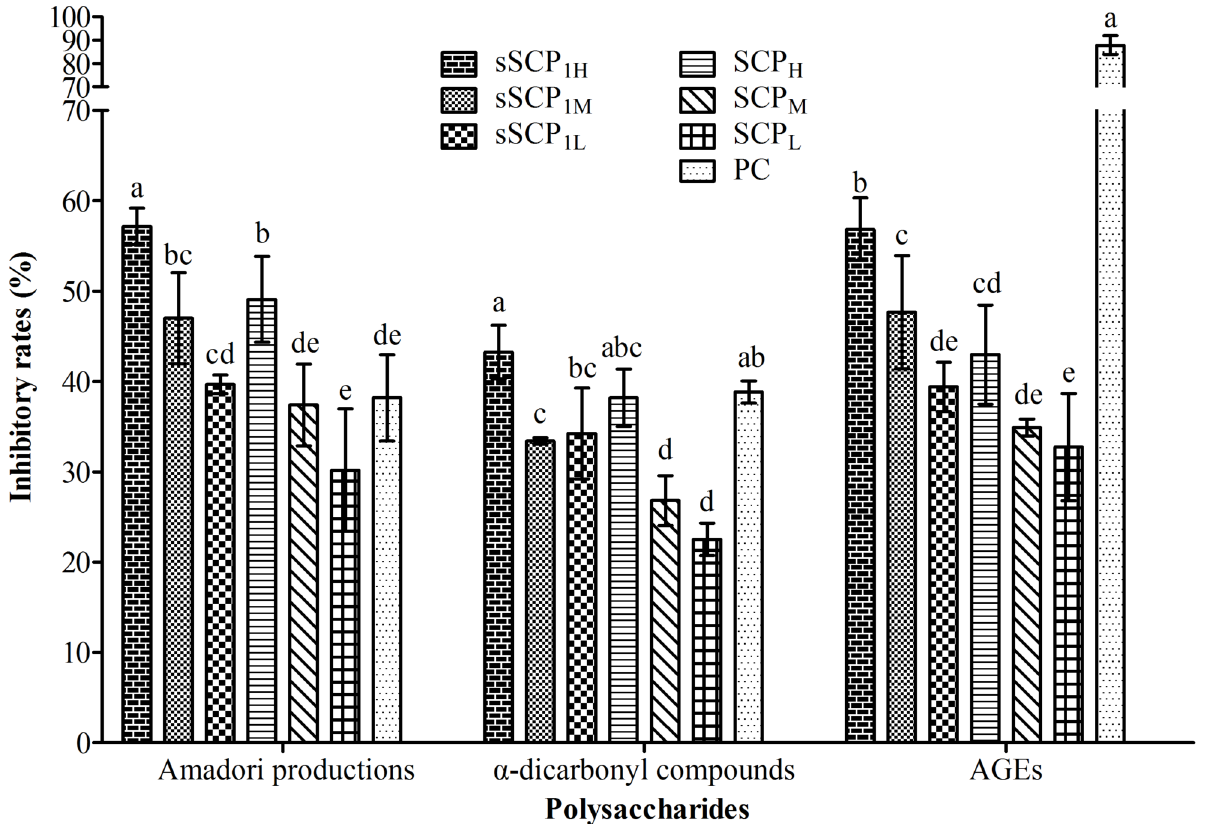
Fig 7. The inhibitory rates of Amadori products, α -dicarbonyl compounds and AGEs in each group. Bars in same concentration without same superscripts (a – e) differ significantly ( P < 0.05).